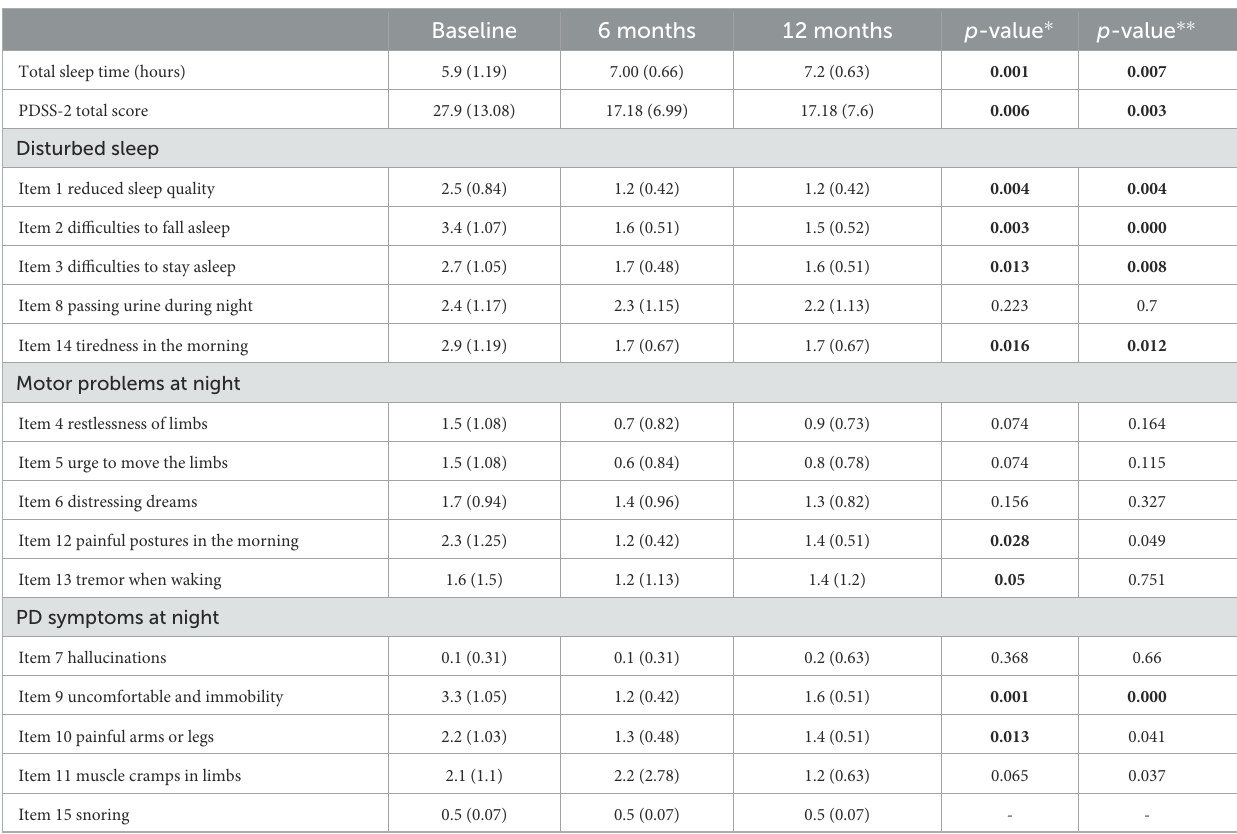
TABLE 3 PDSS-2 in the people with Parkinson’s disease at the baseline and after 6 and 12 months of LCIG infusion. Baseline